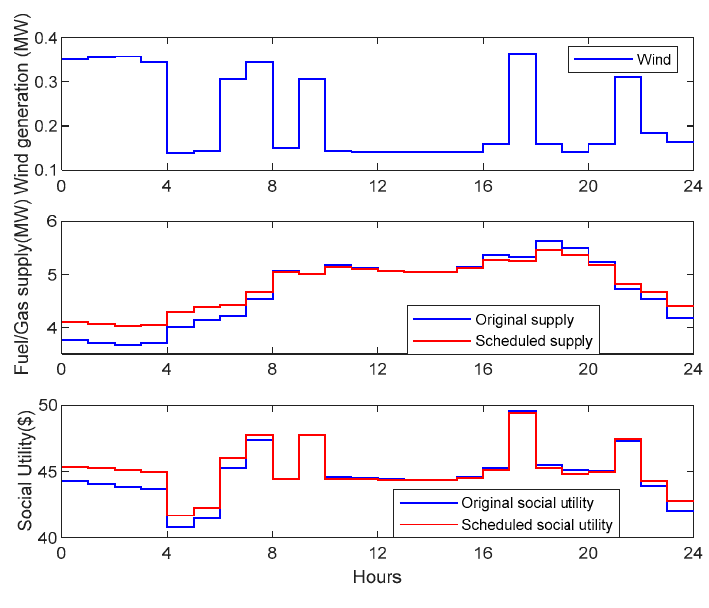
Figure 8. 24 h Figure 8. 24 h comparison.